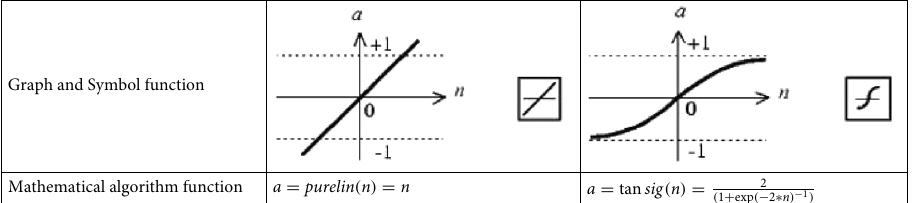
Table 5. Mathematical and graph symbols of activation functions.